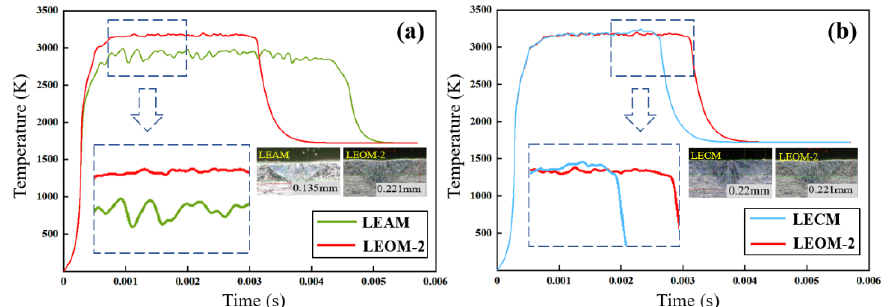
Figure 13. ( a ) Compared with the average temperature of the keyhole center of LEOM-2 and LEAM; ( b ) Compared with the keyhole average temperature of the LEOM-2 and LECM.